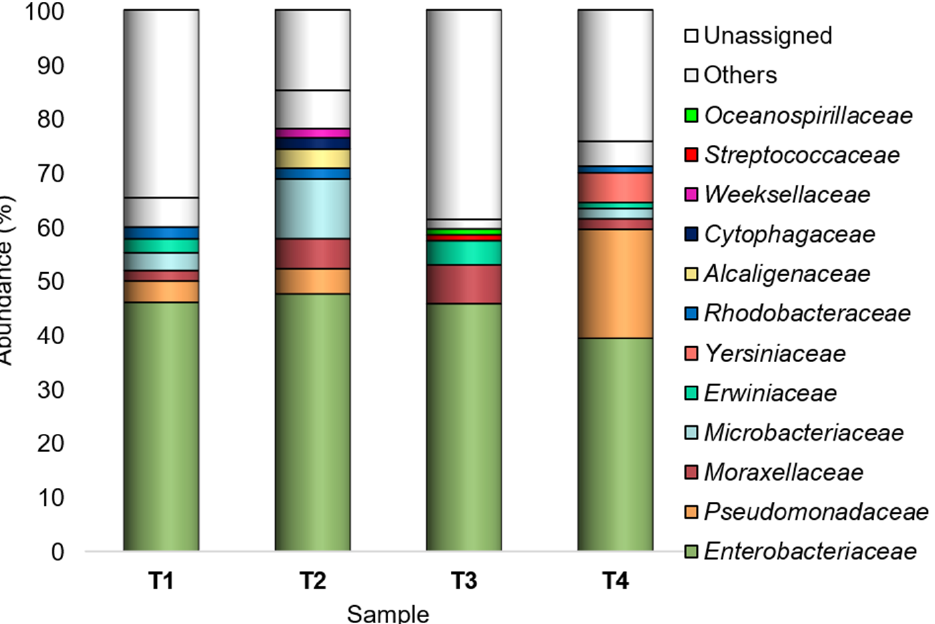
Figure 2. Bacterial composition at the family level. Distribution of the major families (Ra ≥ 1% in at least one sample); families with Ra < 1% were gathered in “Others”. T1: WT/OF, T2: WT/CF, T3: SB/OF, T4: SB/CF.